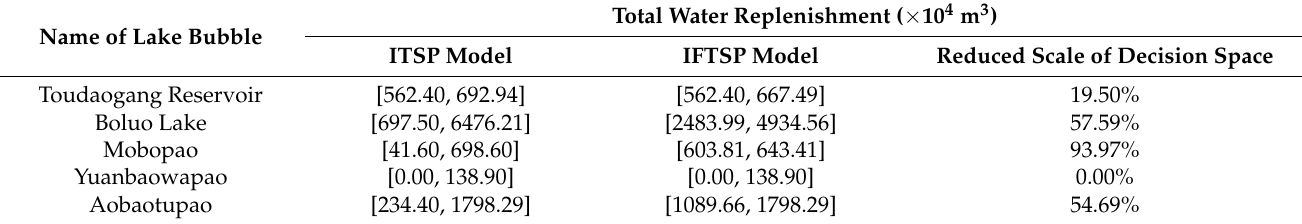
Table 2. Comparison between IFTSP model and ITSP model optimisation schemes for ecological water replenishment of each lake bubble in Boluo Lake National Nature Reserve.